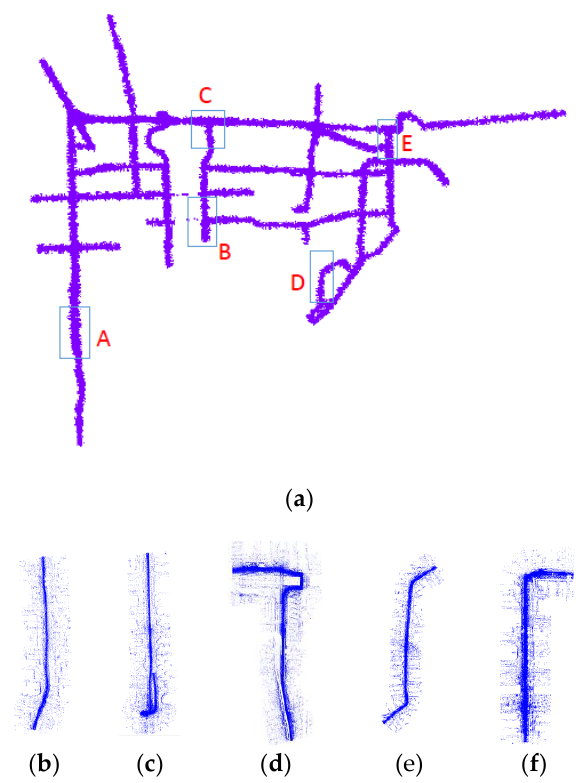
Figure 9. Schematic representation of the study area and the five road-section samples. ( a ) The entire